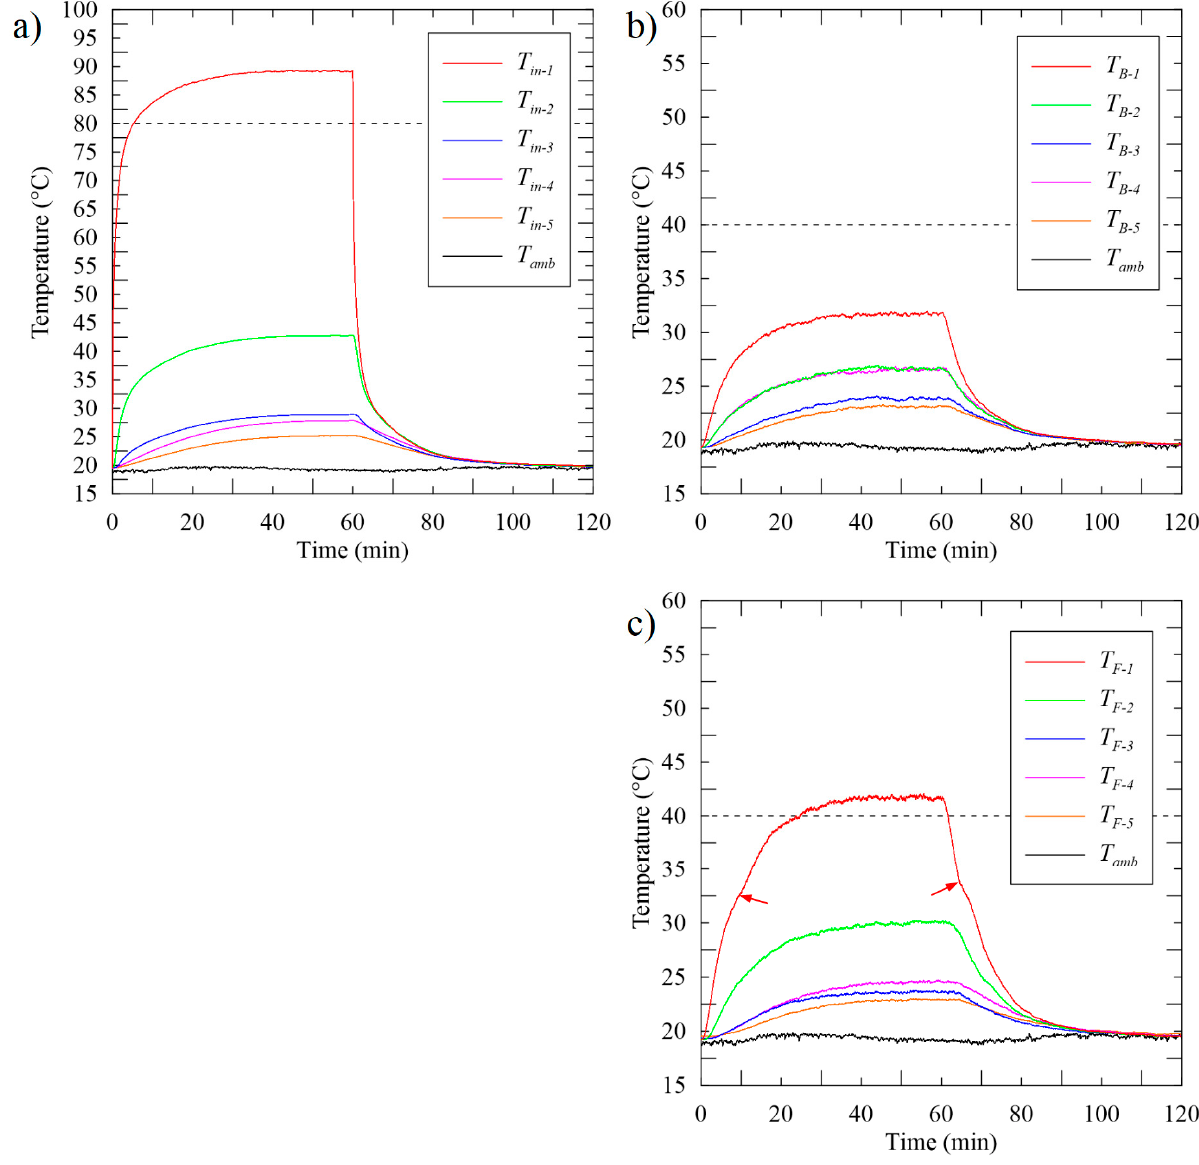
Figure 7. Temperature measurements on the ( a ) inside, ( b ) back cover, and ( c ) display of the mock tablet with the aluminum heat spreader installed and a heat generation rate of 4.5 W (the dashed line represents the relevant temperature limit). Arrows indicate inflection points (see text for discussion).